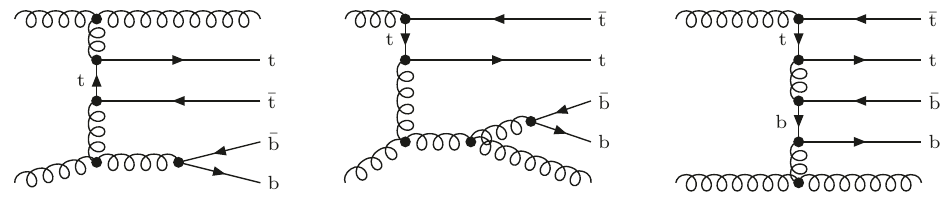
Figure 1. Selected Born diagrams in the gg